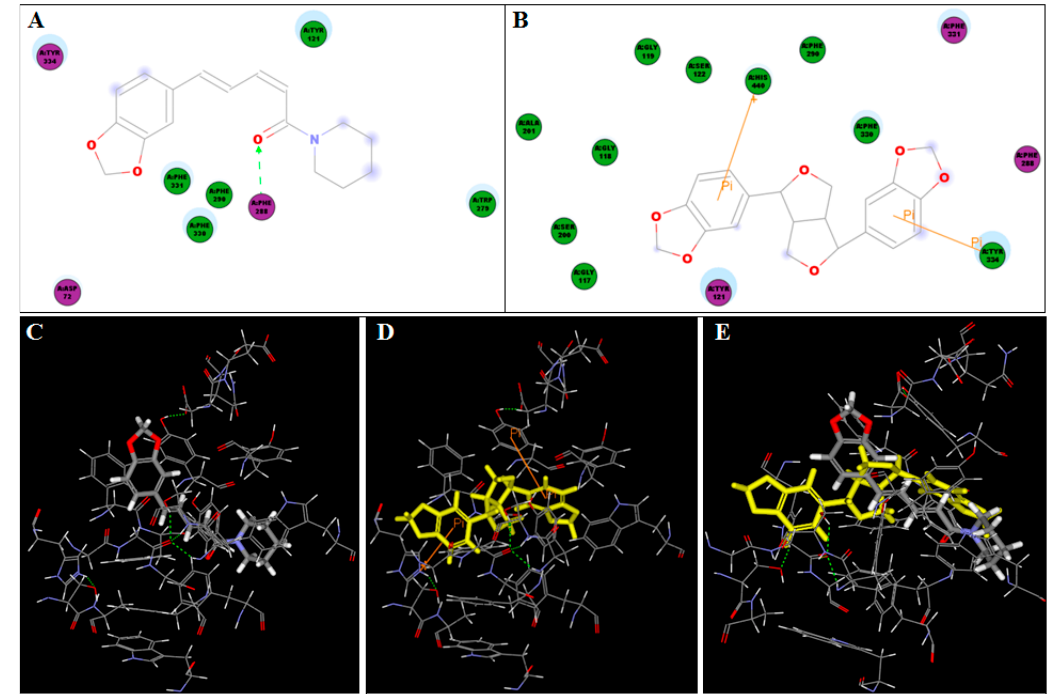
Figure 5. 2D- and 3D-binding diagrams of piperine ( A , C ), sesamin ( B , D ), and the 3D-binding diagram of the two compounds concomitantly ( E ) to AChE crystal structure.